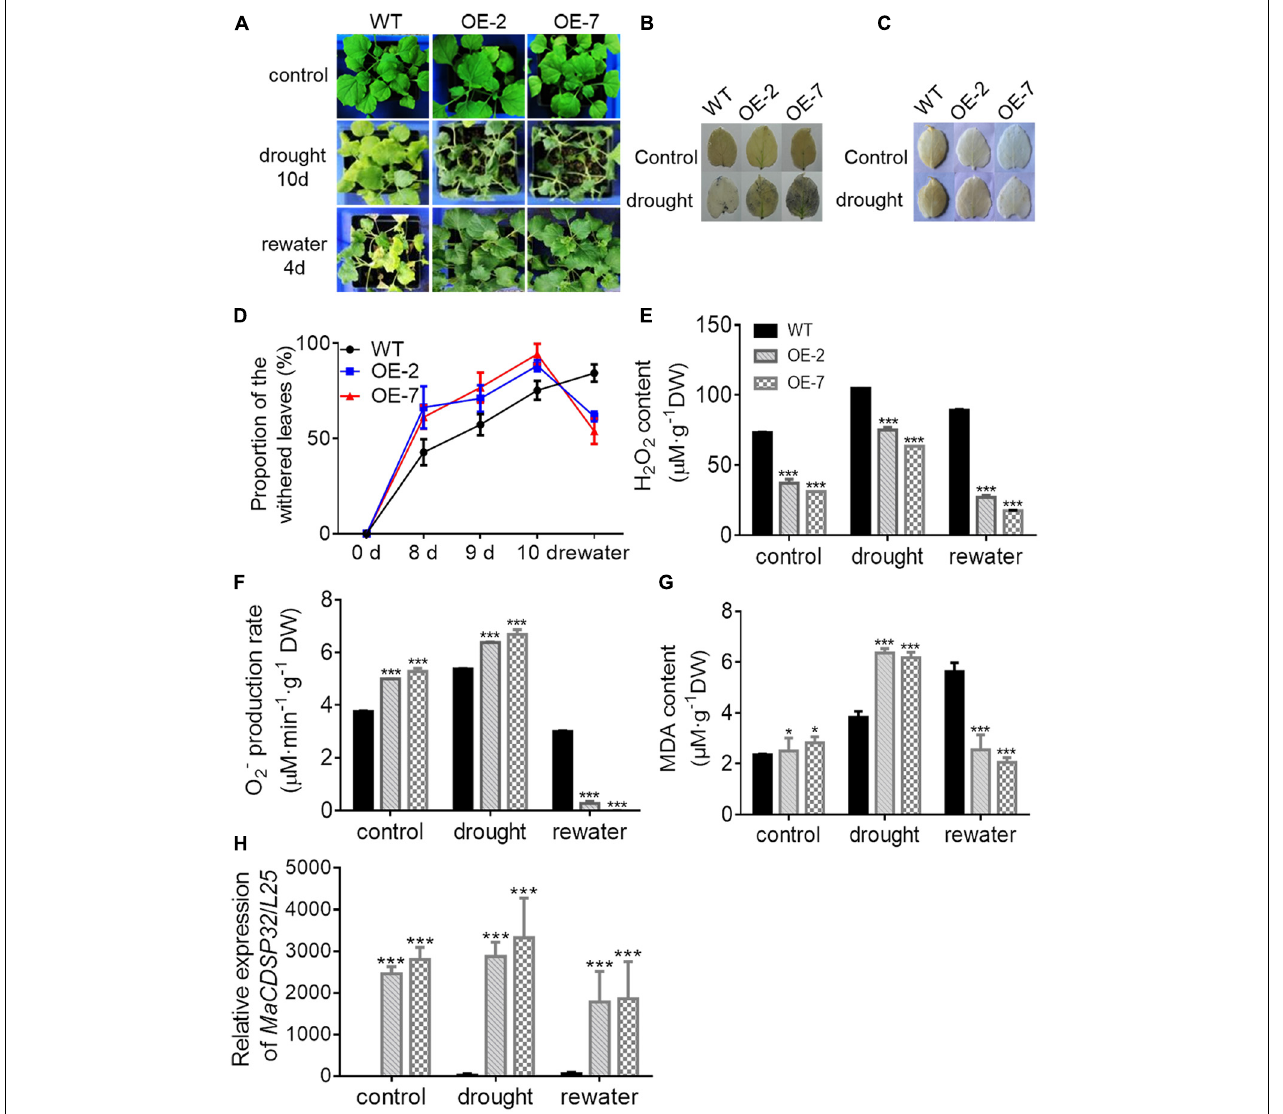
FIGURE 5 | Overexpression of the MaCDSP32 gene increases drought sensitivity but strengthens recovery during post-drought rewatering in transgenic tobacco. (A) Phenotypes of 3-month-old WT plants and two transgenic (OE-2 and OE-7) tobacco lines after 10 days of drought and 4 days of rewatering treatment. (B,C) In vivo histochemical detection of O 2 − (B) and H 2 O 2 (C) after 10 days of drought. (D) Proportions of wilted leaves per plant under the treatment. (E,F) Quantification of H 2 O 2 (E) and O 2 − (F) contents in leaves under the treatment. (G) Malondialdehyde (MDA) content in leaves under the treatment. (H) Gene expression of MaCDSP32 under treatment. At least three biological replicates were included. Asterisks indicate significant differences between the transgenic and WT lines ( t -test, * P < 0.05, *** P <